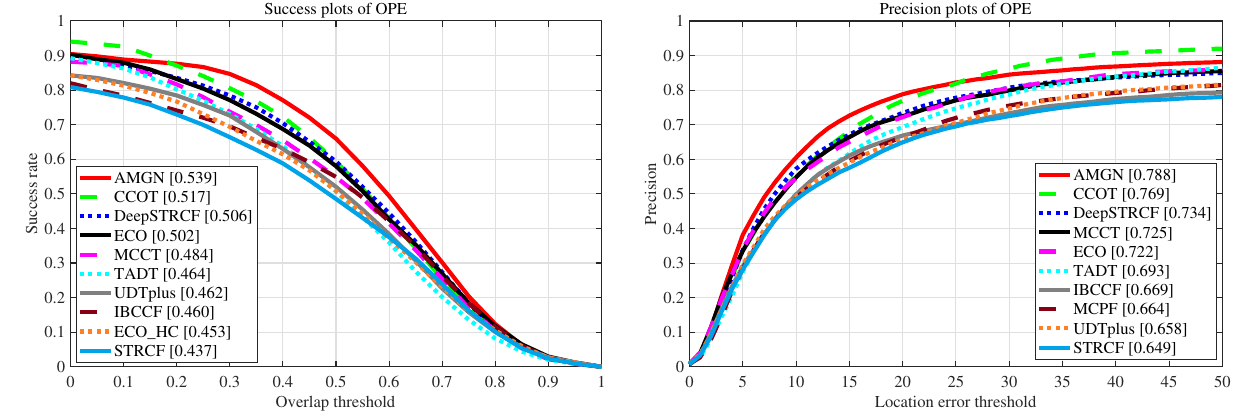
handling deformation challenges. The AUC of the success plot leads the runner-up by 2.3%, and the precision score leads the runner-up by 9.1%